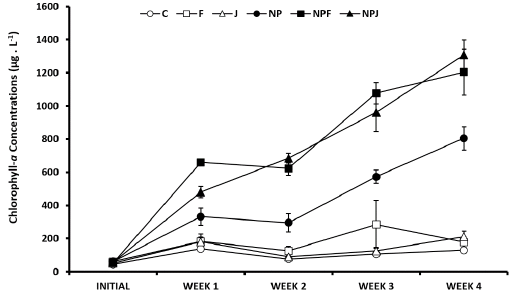
Figure 3. Medium values (+ - SE) for Chlorophyll- a con- centration measurements taken along the experimental period in six combinations of nutrients (NP), fingerlings (F) and juvenile (J) Nile tilapia